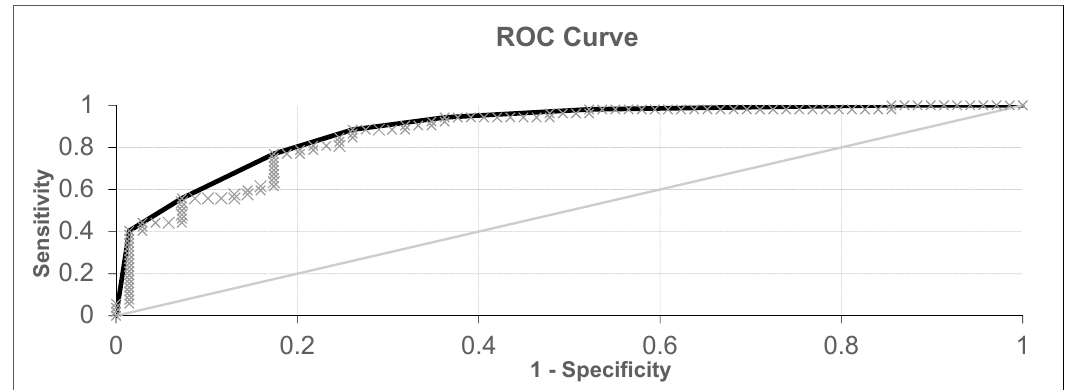
Figure 2. Scatter plot for all healthy patients, patients with laryngeal or oropharyngeal cancer, and patients with lung cancer.